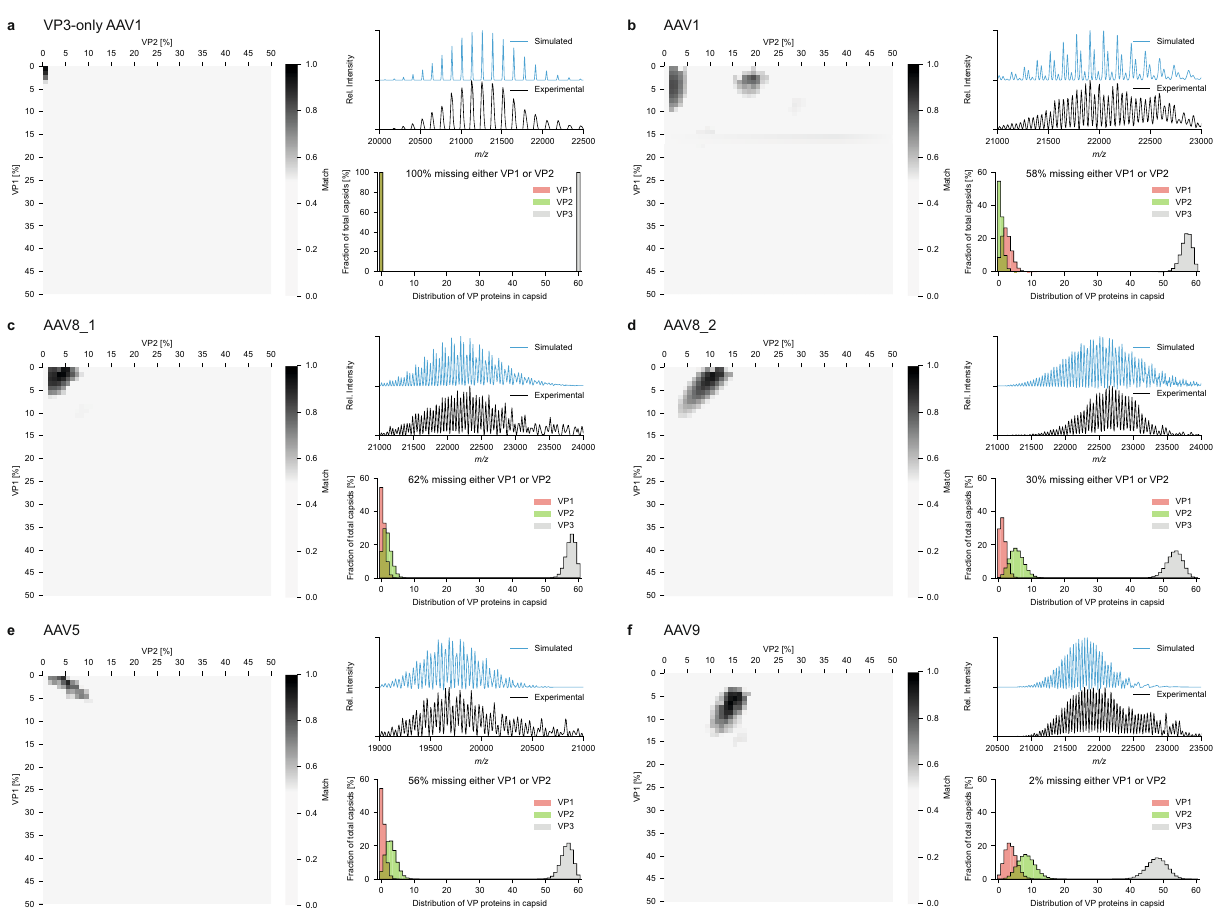
Fig. 5 Top scoring optimized simulations for several distinct AAV products of different serotypes. a – f Scores for the systematic comparison between simulations and experimental mass spectra are displayed for AAV1 VP3-only ( a ) and the wild-type capsids for AAV1 ( b ), AAV8_1 ( c ) and AAV8_2 ( d ), AAV5 ( e ), and AAV9 ( f ). AAV8_1 and AAV8_2 are different batches produced in different laboratories. Simulated mass spectra for the best scoring bulk VP ratios are shown with the experimental data alongside the corresponding probability histograms for capsids having a certain number of VP1, VP2, or VP3. Best scoring bulk VP ratios for each serotype are listed in Table 1. The amount of capsids missing either a VP1 or VP2 are indicated above the histograms and range between 100% for AAV1 VP3 only ( a ) and 2% for AAV9 ( f